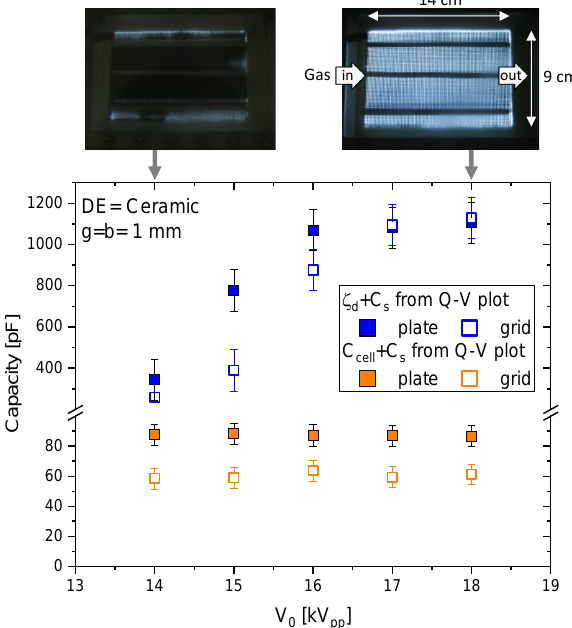
Figure 4. The values of the slopes of Q-V plots for DBDs with g = b = 1mm and ceramic dielectrics at different high-voltage amplitudes V 0 in pure CO 2 . The top of the diagram shows two top-view photos of the reactor with grid electrodes under operation at 14 and 18kV pp , respectively.